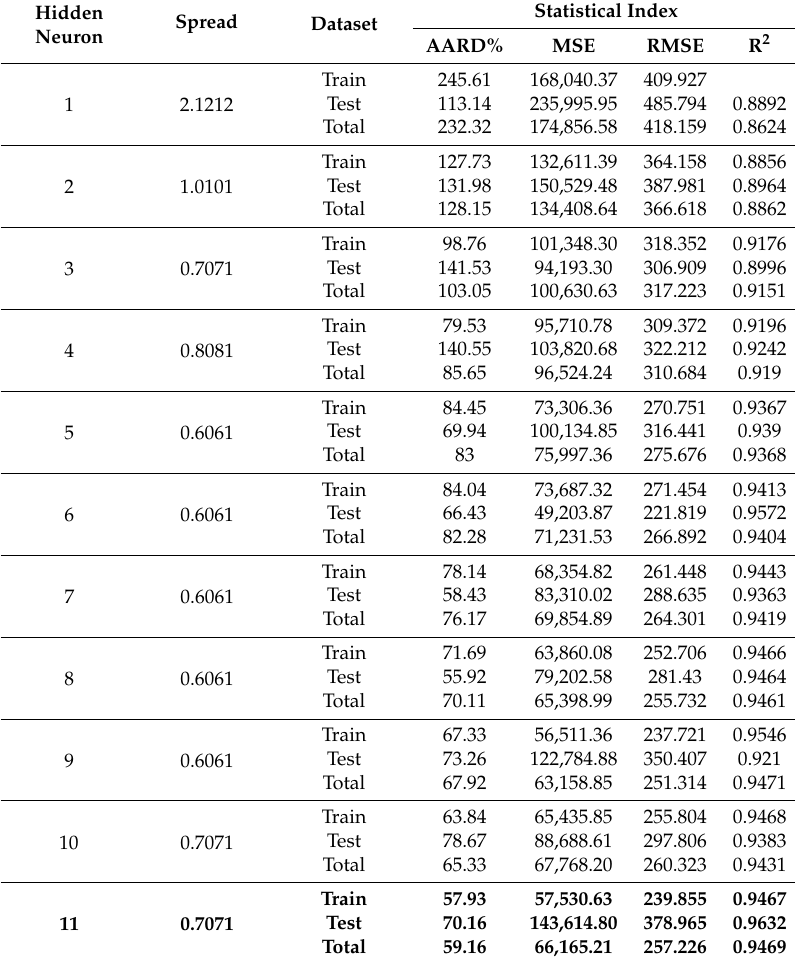
Table 6. Performance of radial basis function (RBF) model with di ff erent hidden neurons.